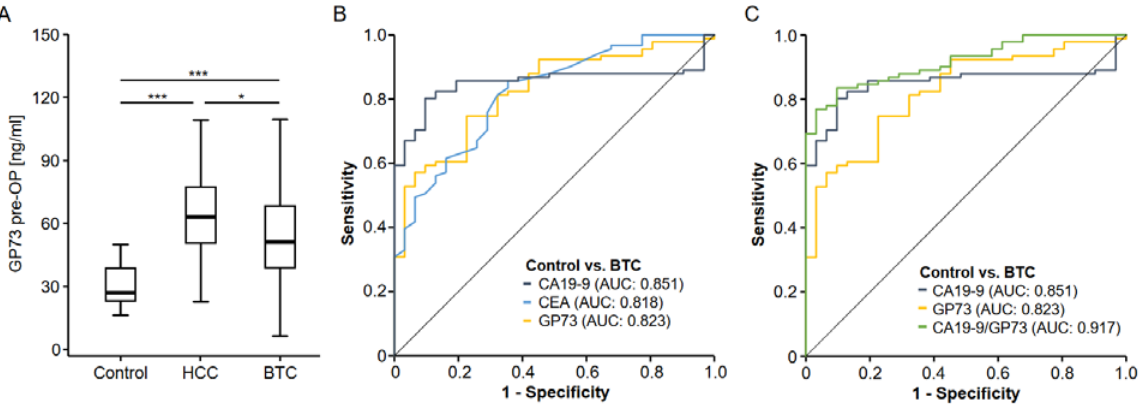
Figure 1. Circulating levels of GP73 in HCC and BTC patients. ( A ) Patients with hepatocellular carcinoma (HCC) and biliary tract cancer (BTC) both have significantly increased GP73 serum levels compared to healthy controls. The induction of circulating GP73 is significantly stronger in HCC compared to BTC. * p < 0.05; *** p < 0.001. ( B ) Circulating GP73 levels show a slightly lower AUC value than CA19-9 but a similar AUC value compared to CEA serum levels. ( C ) The combination of GP73 and CA19-9 serum levels has the AUC value for the identification of BTC cancer patients.